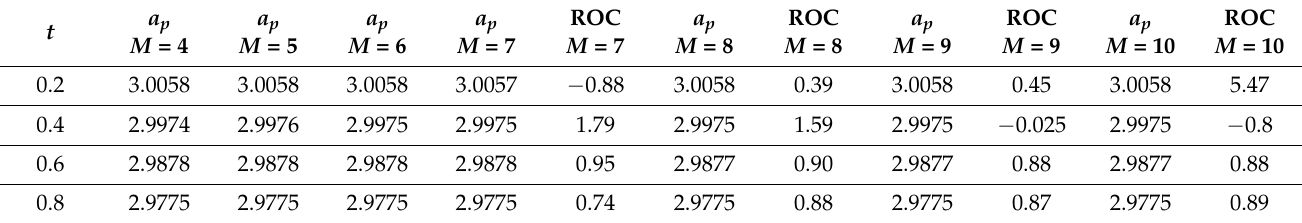
Table 5. The values of a p and rate of convergence (ROC) at different points for k = 2 and various values of M by Bernoulli wavelets.